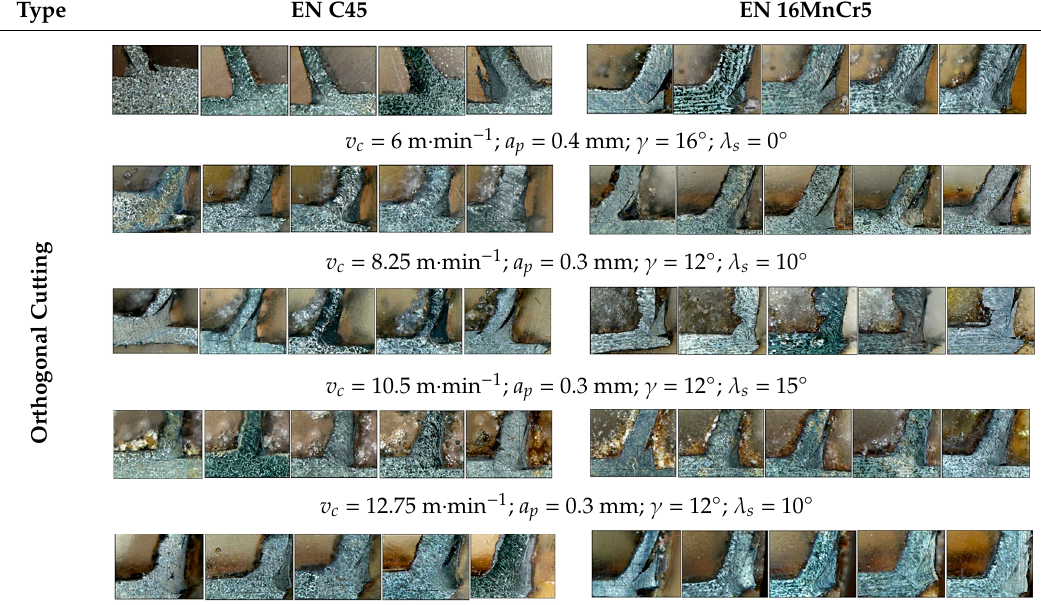
λ s ; ( a ) orthogonal cutting; ( b ) oblique cutting.